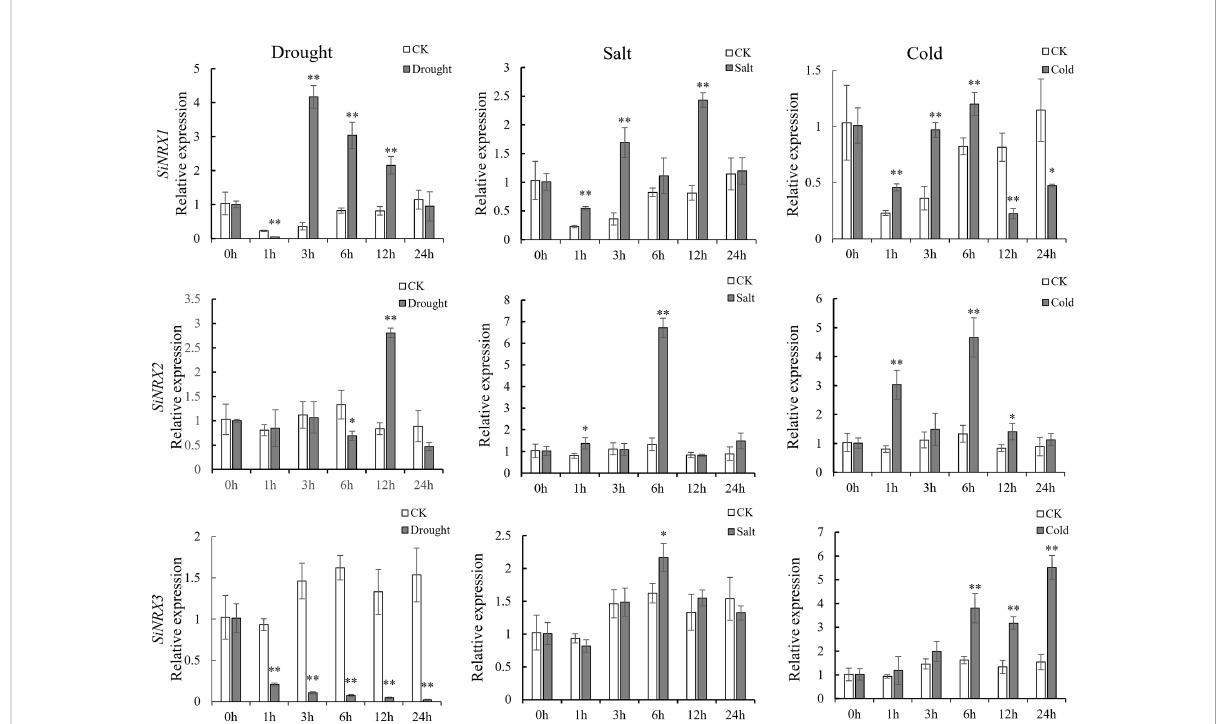
FIGURE 3 Expression patterns of SiNRX1 , SiNRX2 , SiNRX3 under abiotic stresses. qRT-PCR analysis of SiNRX1 , SiNRX2 , and SiNRX3 in foxtail millet leaves in response to diverse treatments (drought [20% PEG6000), salt (100 mM NaCl), and cold (4°C)]. CK as control (without stress treatment). Standard deviations are indicated by error bars (mean ± SD and n = 3). Each time point was compared to the control group, and student ’ s t-test was used to calculate signi fi cance: *indicates p <0.05, and **indicates p